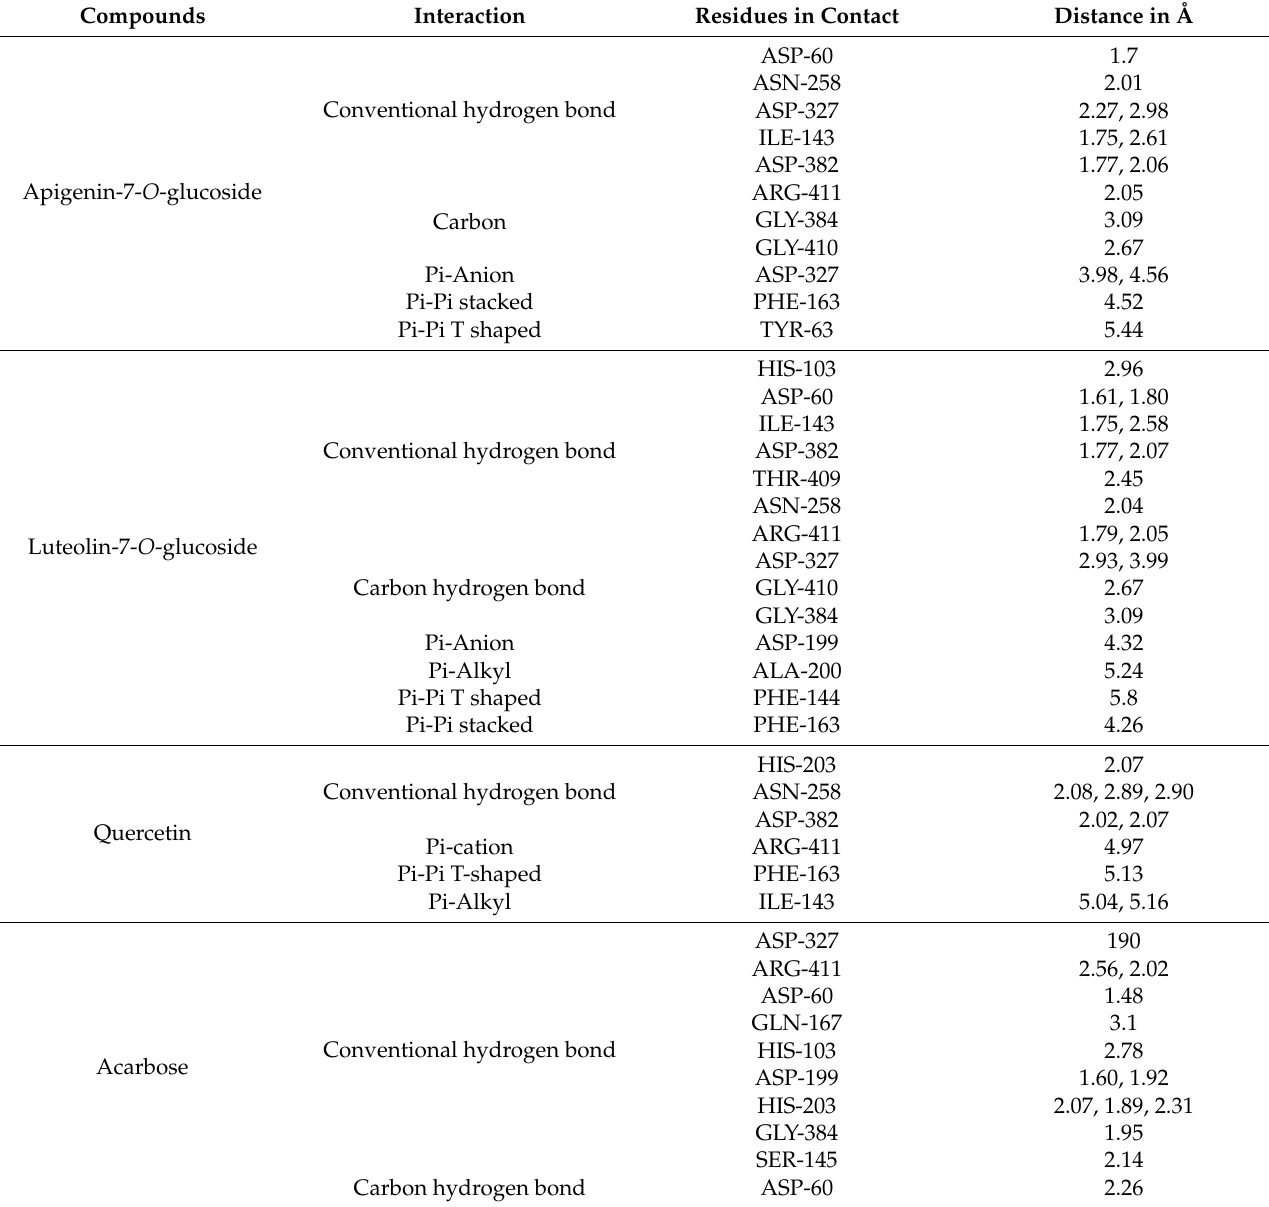
Table 2. Data for the molecular docking of apigenin-7- O -glucoside, luteolin-7- O -glucoside, quercetin, and control acarbose with alpha-glucosidase